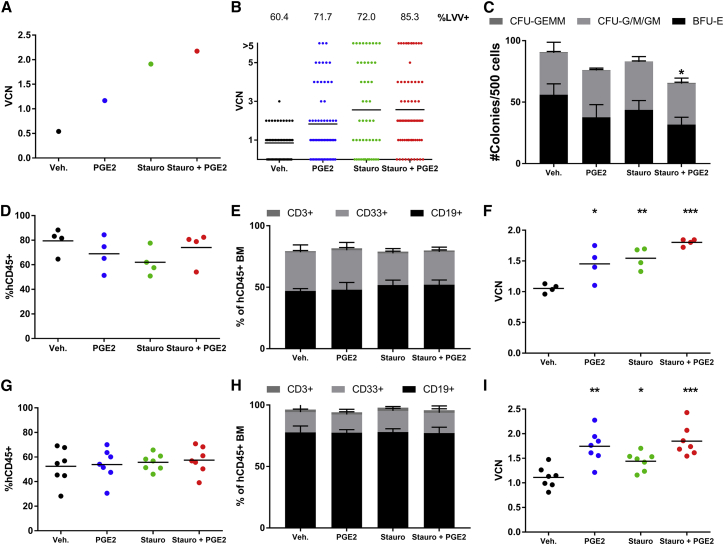
Combination Staurosporine and PGE2 Treatment Increases Transduction of Human Short-Term NSG Repopulating Cells(A) VCN analysis of pooled methylcellulose colonies of retained cells (graft) representing what was transplanted into NSG recipients. (B) Individual colony qPCR of graft with %LVV+ colonies quantified above each column. (C) Colony enumeration from retained cells plated in methylcellulose. Error bars are 1 SD. (D) Engraftment of human CD45+ cells in BM of NSG recipients 2 months post-transplant, n = 5 mice/group. (E) Stacked bar graph depicting myeloid and lymphoid populations present in human CD45+ engrafted cells 2 months post-transplant. (F) VCN analysis of BM 2 months post-transplant. (G) Engraftment of human CD45+ cells in BM of NSG recipients 4 months post-transplant, n = 10 mice/group. (H) Stacked bar graph depicting myeloid and lymphoid populations present in human CD45+ engrafted cells 4 months post-transplant. (I) VCN analysis of BM 4 months post-transplant. Statistical significance is determined relative to vehicle-treated control. *p < 0.05, **p < 0.005, ***p < 0.0005.